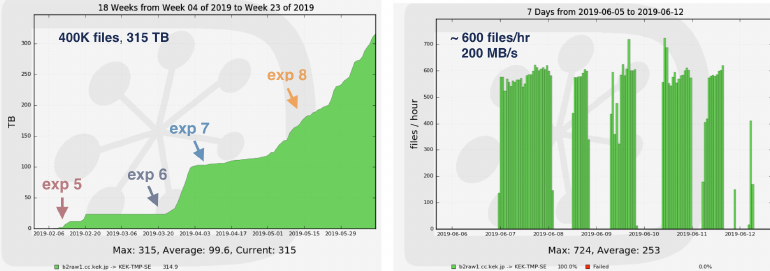
Figure 5. (Left) Cumulative data processed by BelleRawDIRAC. To the date, 400K raw data files have been uploaded, registered and replicated, corresponding to 315 TB. (Right) Throughput of upload and registration during a normal operation day. In average, 253 files are being registered per hour, with a sustained throughput of ∼ 600 files per hour.